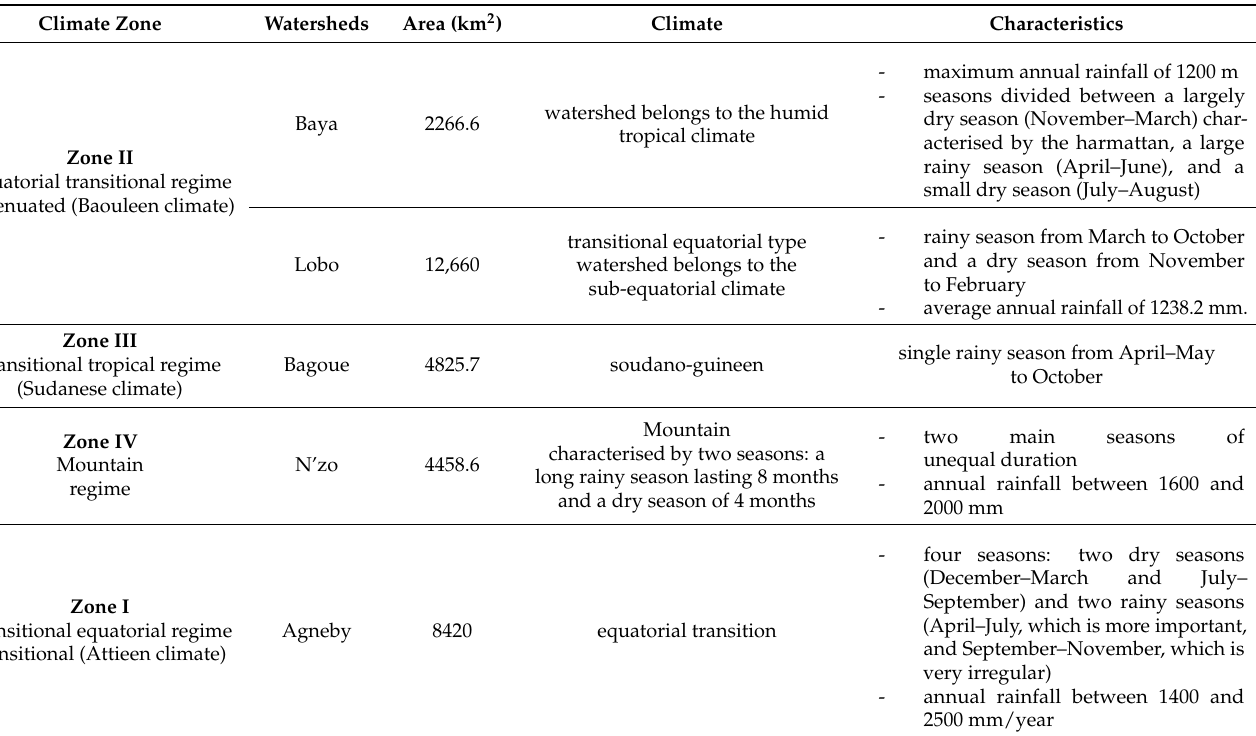
Table 1. Characteristics of the selected